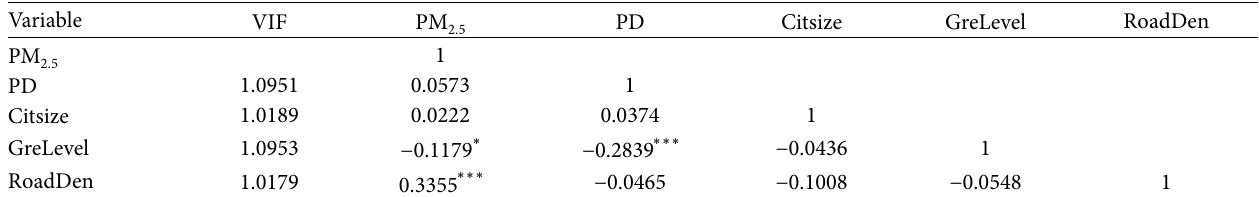
Table 2: Correlation matrix between independent variables and VIF